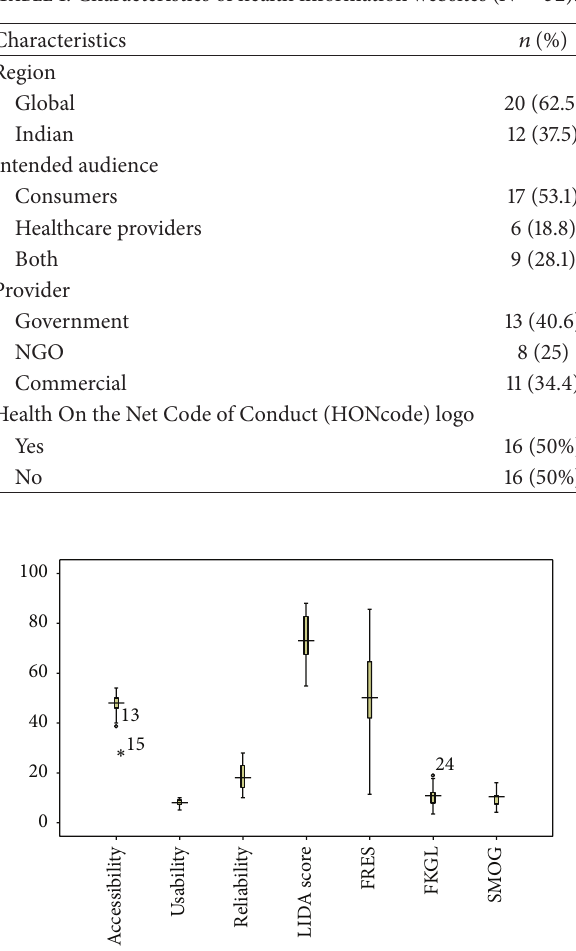
Table 1: Characteristics of health information websites ( 𝑁 = 32 ).